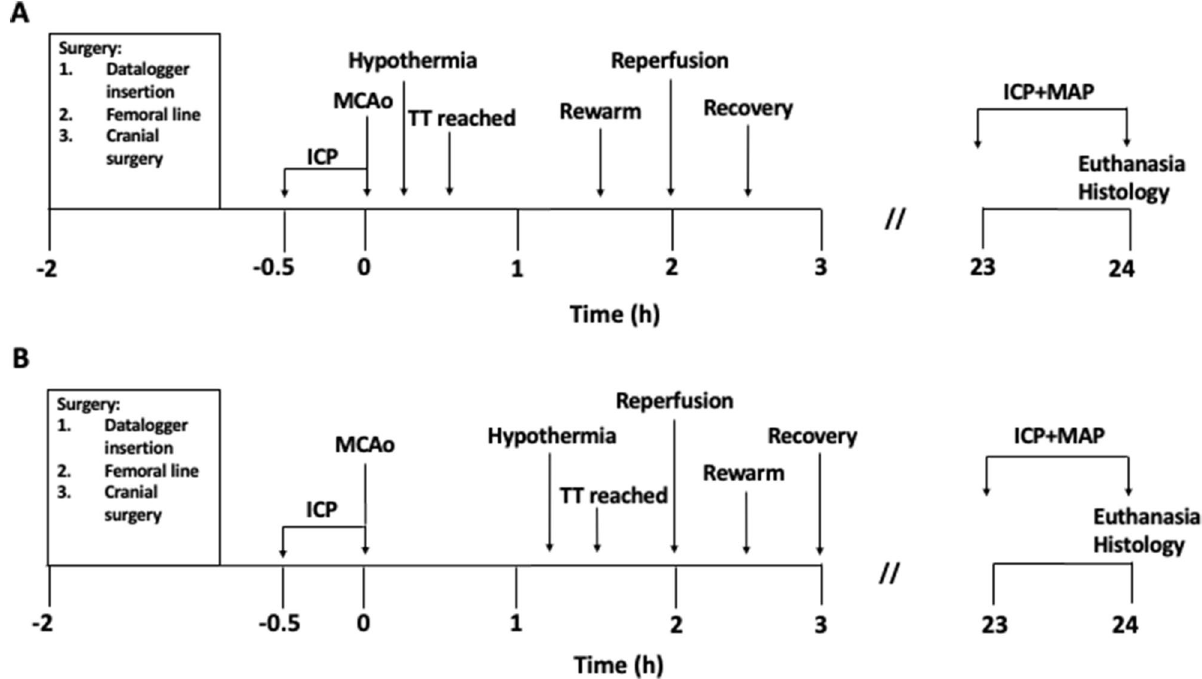
Figure 5. Experimental timeline of hypothermia treatment groups. ( A ) Shows the timeline for the rewarmed pre-reperfusion group, where hypothermia-rewarming is completed prior to reperfusing the rat at 2 h post- stroke. ( B ) Shows the timeline for the rewarmed post-reperfusion group, where hypothermia-rewarming is completed after reperfusion. ICP intracranial pressure, MCAo middle cerebral artery occlusion, TT target temperature, MAP mean arterial blood